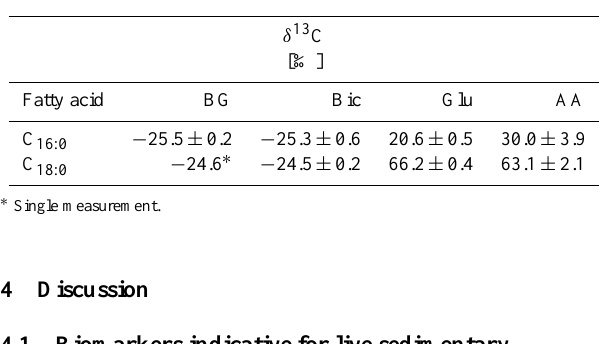
Table 4. δ 13 C values of fatty acids measured in the 0–1cm slice in cores from station 3, incubated without inhibitor, for